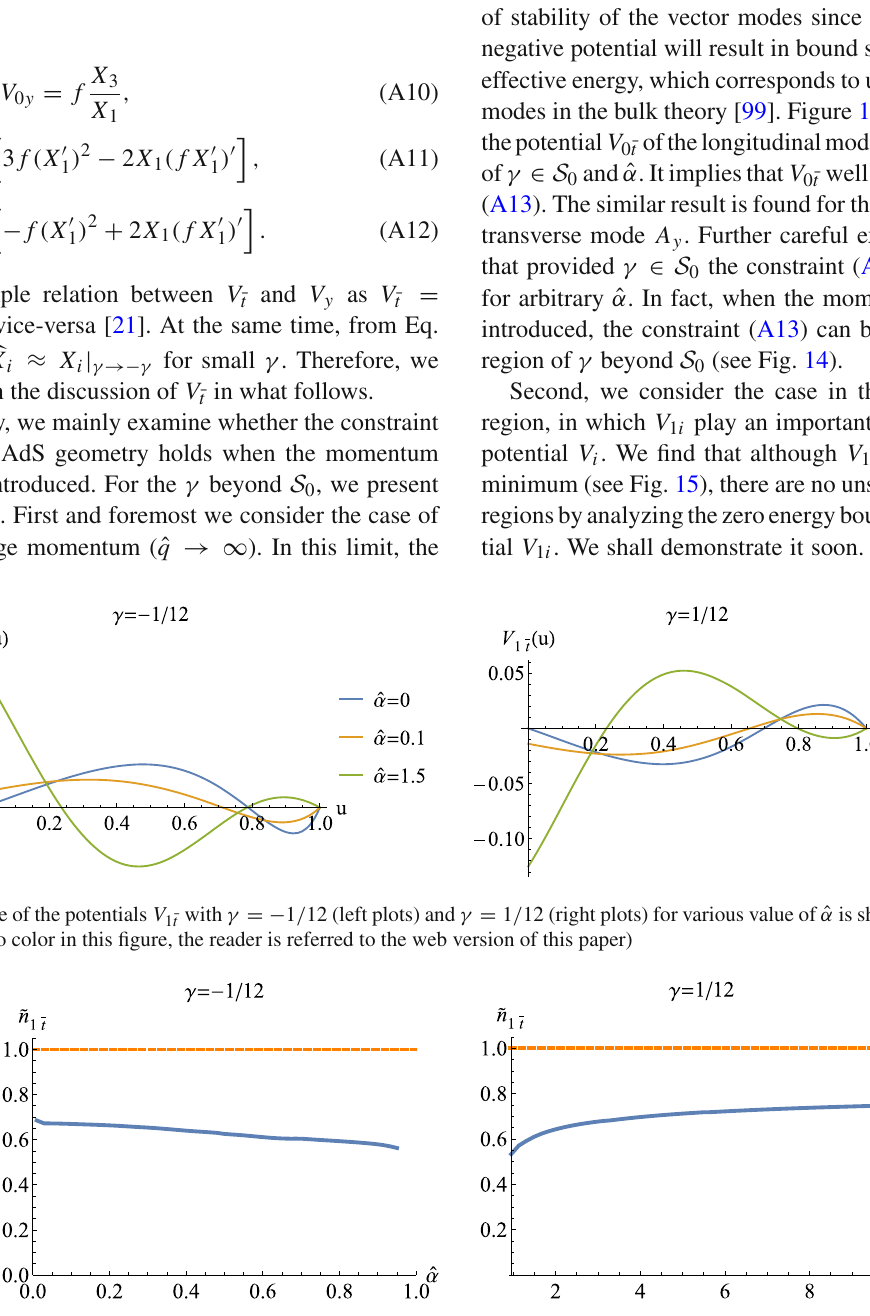
Fig. 16 ˜ n 1 ¯ t as the function ˆ α for given γ in the region of ˆ α in which a negative potential develops close to horizon. These plots clearly exhibit that ˜ n 1 ¯ t is always less than unit. (For interpretation of the references to color in this figure, the reader is referred to the web version of this